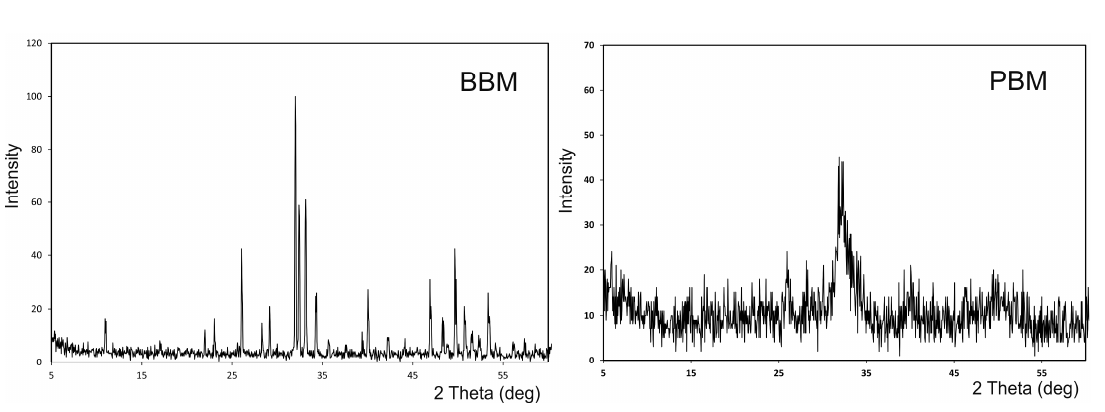
Figure 3. X-ray diffraction pattern of the BBM and PBM materials.